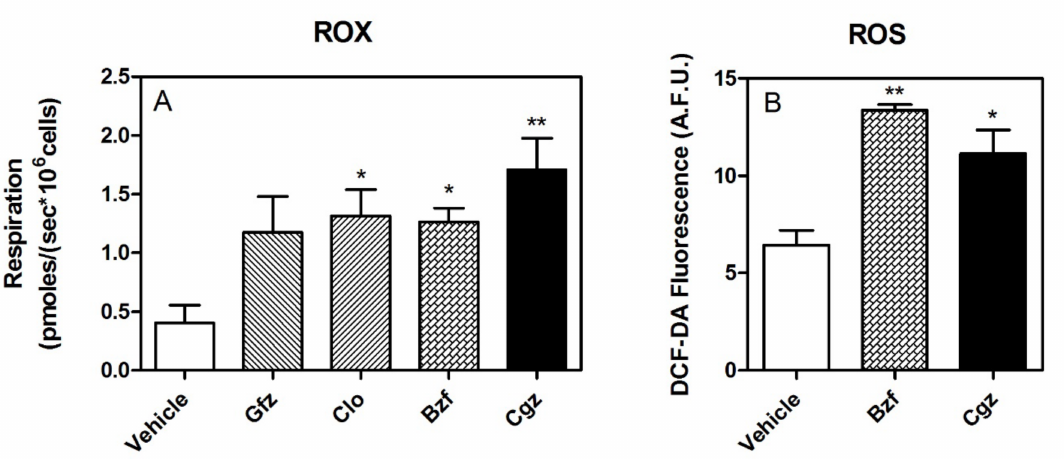
Figure 5. ROX and ROS. Panel ( A ): Residual oxygen consumption (ROX), measured after inhibition of the ERC in treated and untreated HepG2 cells. Panel ( B ): Intracellular ROS levels in the HepG2 cells upon treatment with 50 µ M CGZ and 1 mM BZF. ROS data, expressed as arbitrary fluorescence units (A.F.U.), are the means ± SEM of four replicates from each condition (* p < 0.05 and ** p < 0.01).